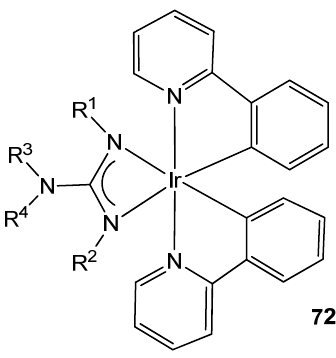
Figure 44. Luminescent iridium guanidinato compound.